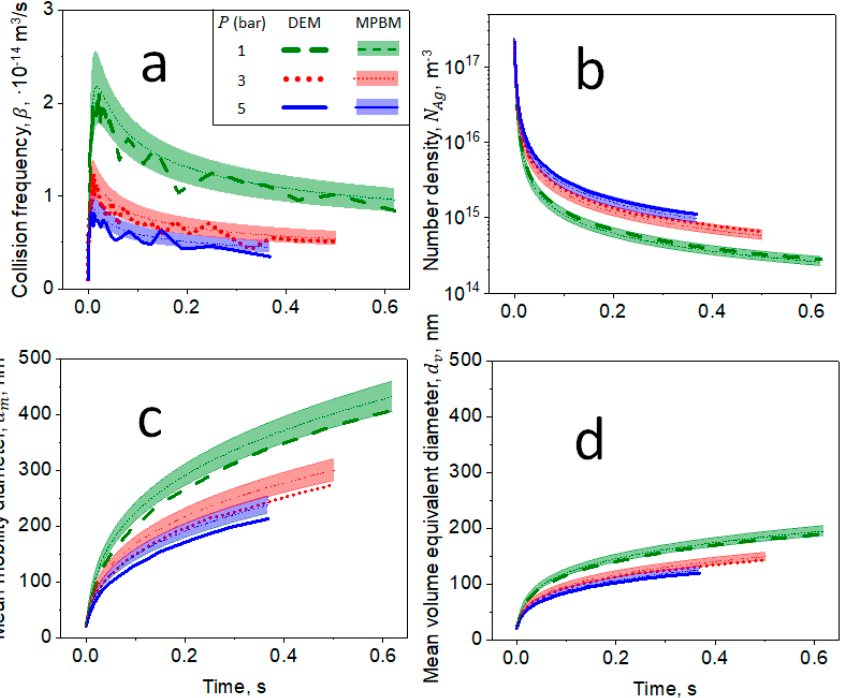
Figure 5. Evolution of ( a ) β , ( b ) N Ag , ( c ) d m and ( d ) d v as a function of t for agglomerates consisting of primary particles with mean d p = 20 nm and σ g , p = 1 at T = 1830 K and P = 1 (broken line), 3 (dotted line) and 5 bar (solid line) simulated by DEM (thick lines) and MPBM (thin lines and shades). All sub-figures ( a – d ) share the same